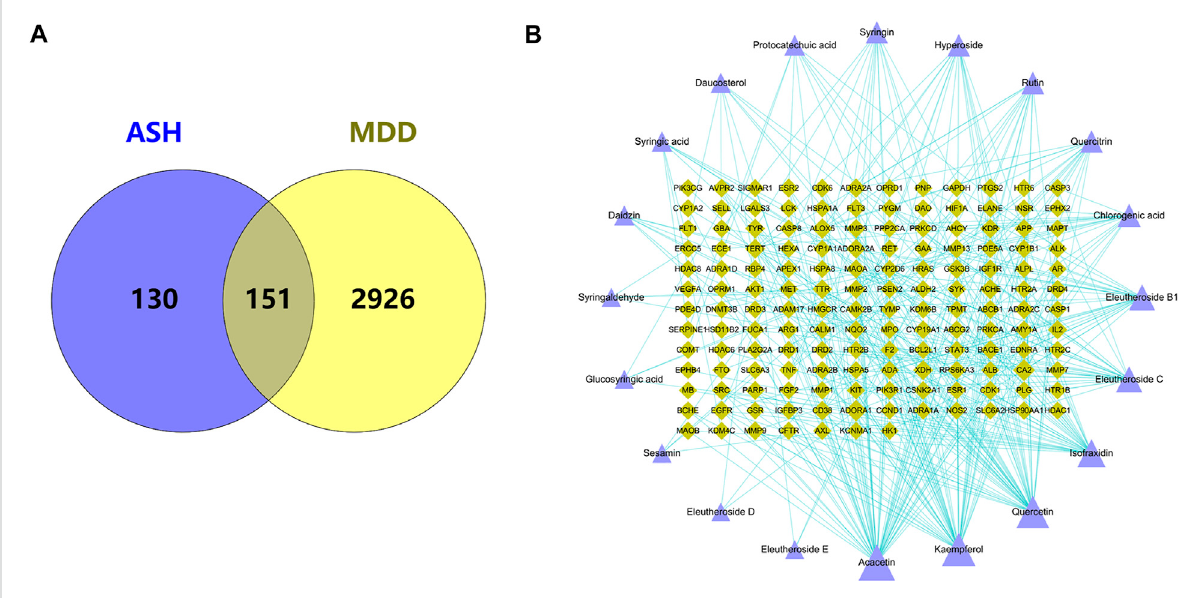
FIGURE 2 (A) Overlapping target genes between MDD and ASH. (B) Drug-active ingredients and disease target network. Purple triangle: active compounds; green diamond: targets. The bigger nodes represent greater